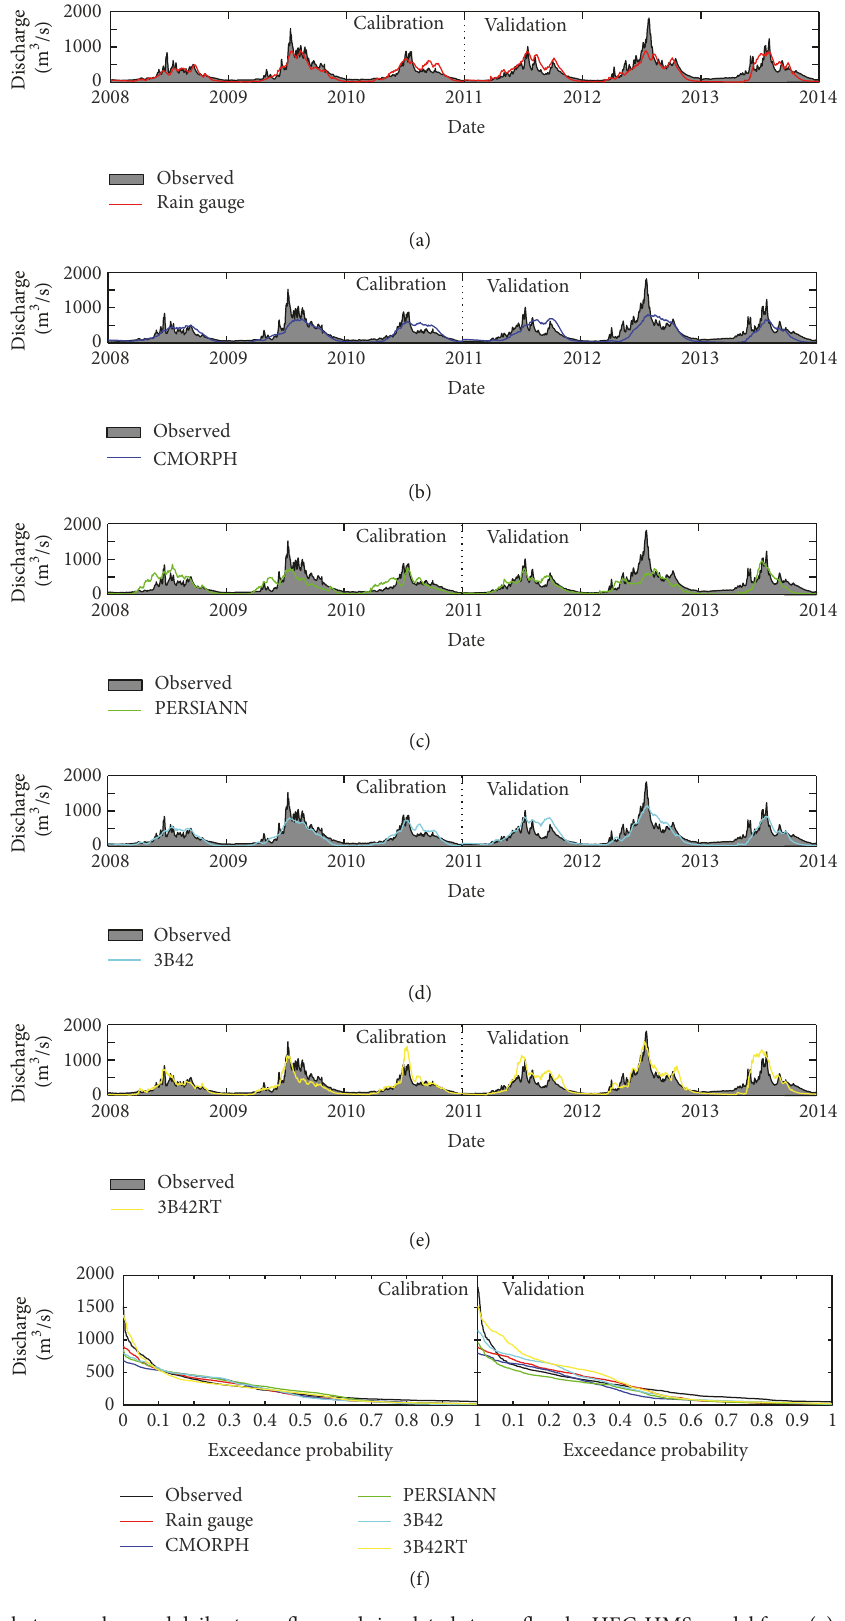
Figure 9: Comparison between observed daily streamflow and simulated streamflow by HEC-HMS model from (a) gauge observations, (b) CMORPH-CRT, (c) PERSIANN-CDR, (d) 3B42RT, and (e) 3B42 with benchmarked model parameter values by gauge observations; and (f) is the exceedance probabilities of daily streamflow, during the calibration (2008.1.1–2010.12.31) period and validation (2011.1.1–2013.12.31)